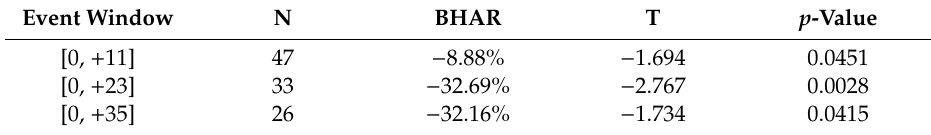
Table 7. BHARs results by three-factors